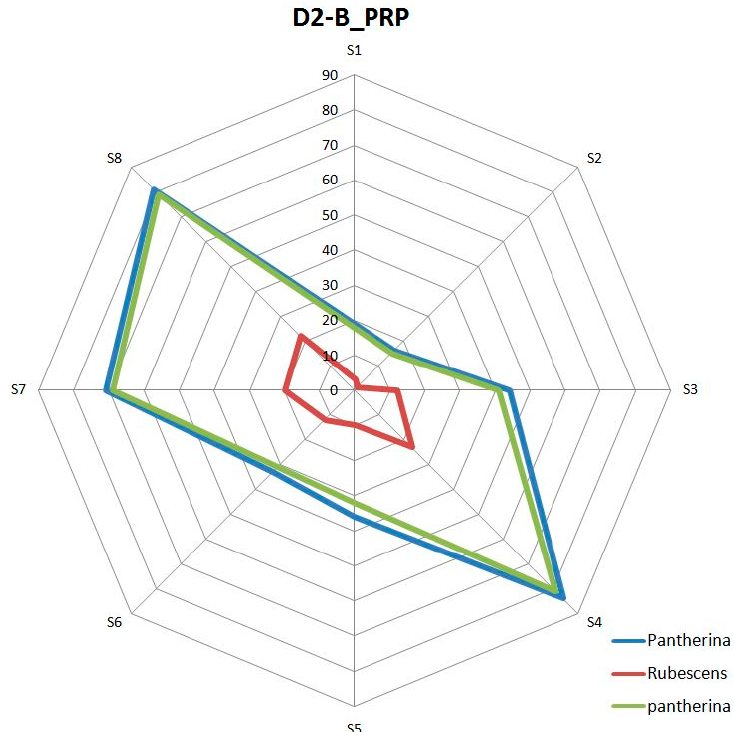
Foods 2019 , 8 , 414 11 of 19 Figure 6. Graphical representation of the aromas obtained from the triangle D2-B_PRP.